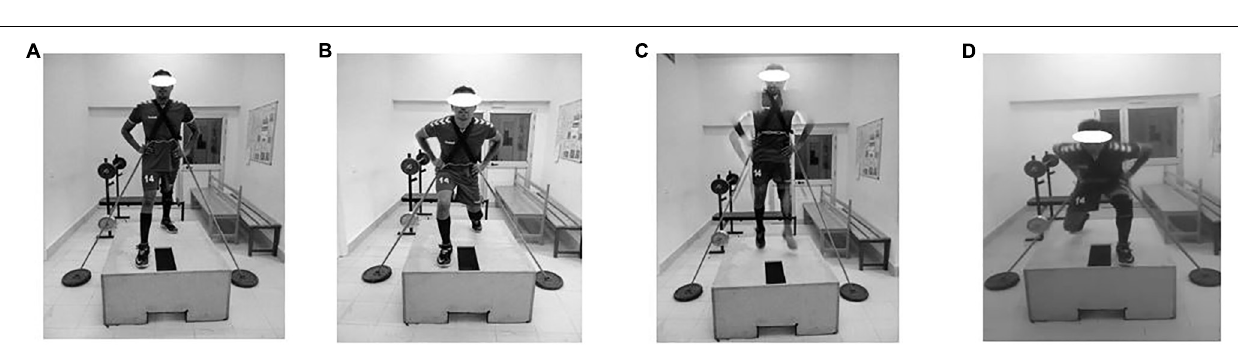
FIGURE 2 | Phases of split squat jump. (A) Starting position, (B) Drop countermovement phase, (C) Flight phase, and (D) Reption